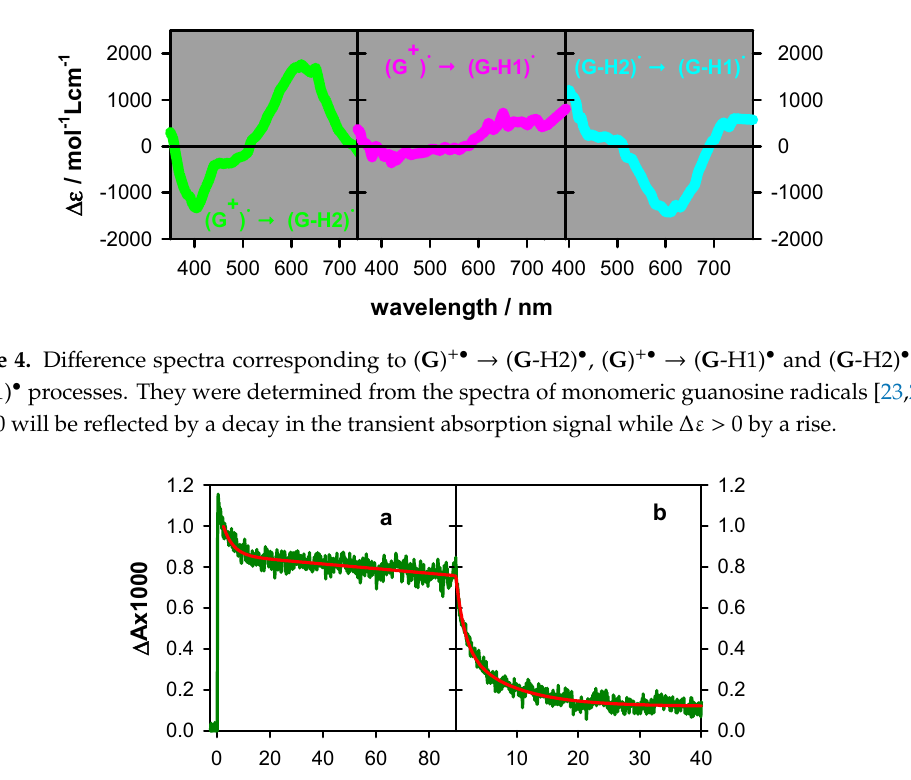
Figure 4. Difference spectra corresponding to ( G ) + • → ( G -H2) • , ( G ) + • → ( G -H1) • and ( G -H2) • → ( G - H1) • processes. They were determined from the spectra of monomeric guanosine radicals [23,24]. ∆ε